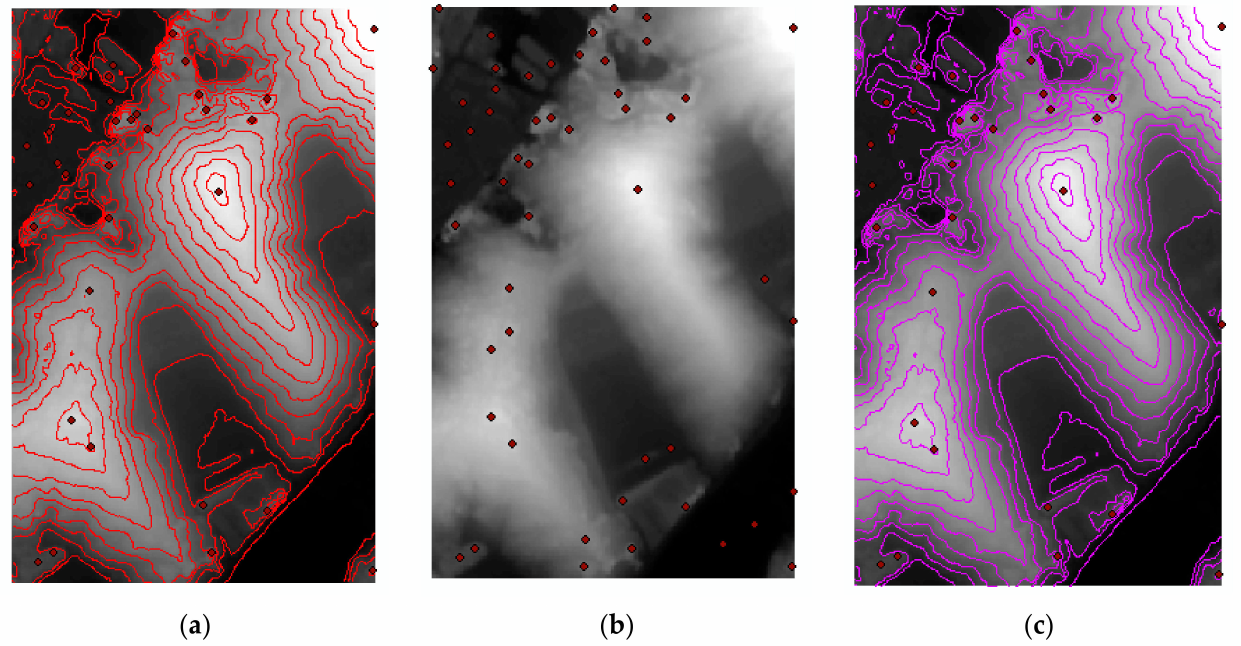
Figure 22. Distribution maps extracted by the traditional Mountain Vertices Extraction Methods using the fourth dataset. ( a ) Contour Line Method. ( b ) Neighborhood Analysis Method. ( c ) Contour line and Neighborhood Analysis Overlay